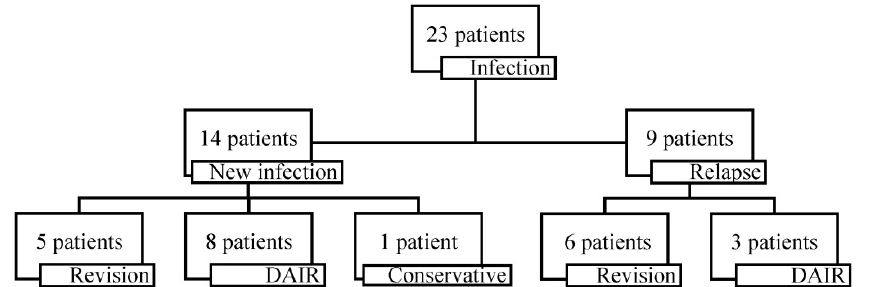
Figure 2: Reinfections, divided by new infections and relapses, and how reinfections were treated.